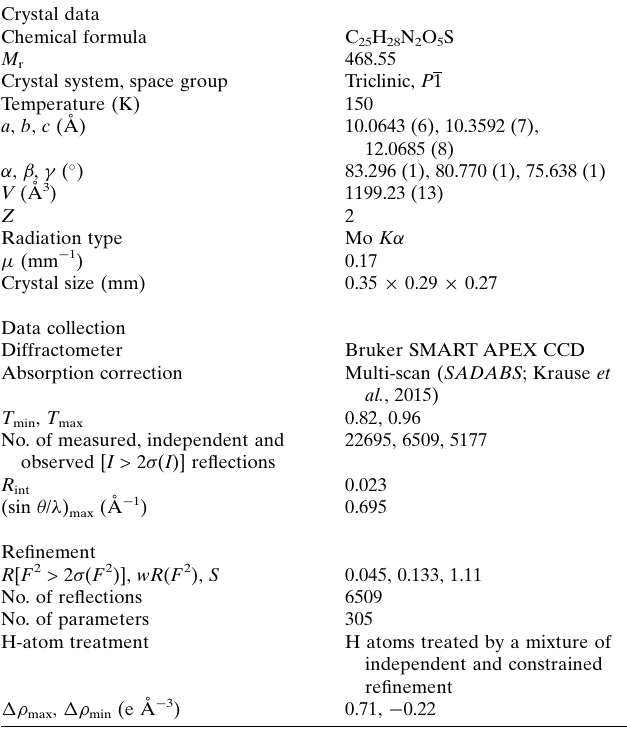
Table 3 Experimental details. Crystal data Chemical